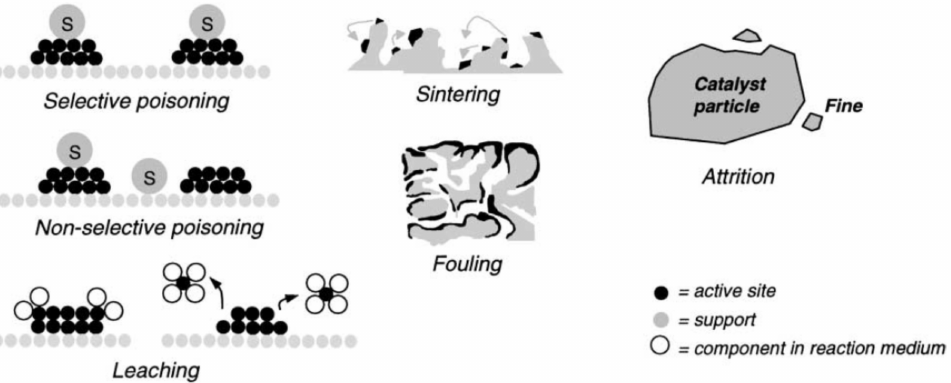
Figure 19. Illustration of the most relevant types of deactivation through heterogeneous catalysis [72]. Reprint with permission from J.A Moulijn, A.E van Diepen, F Kapteijn, Catalyst deactivation: is it predictable?: What to do?, Applied Catalysis A: General, Volume 212, Issues 1–2, 2001, Pages 3–16; Copyright 2001, Elsevier.